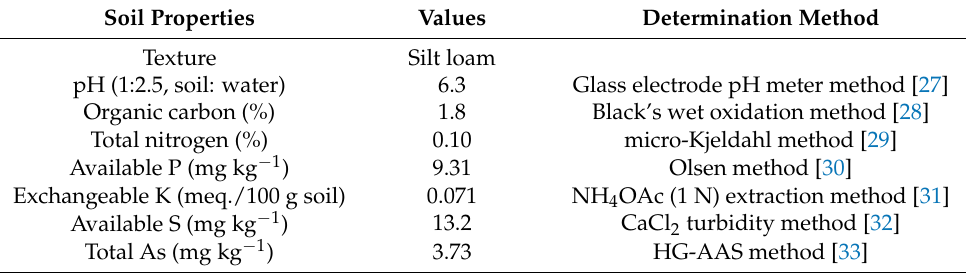
Table 1. Physicochemical properties of the